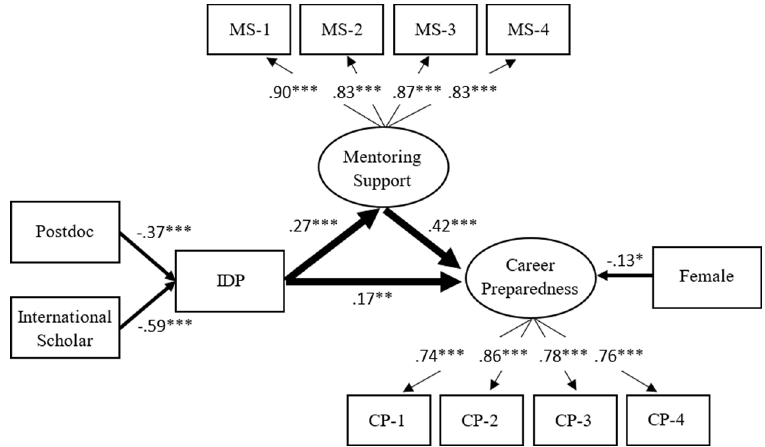
Figure 2. Model 1: Individual development plan (IDP) as a key factor for mentoring support and career preparedness. Note. Value is standardized path coefficient. The values on the light arrows are standardized